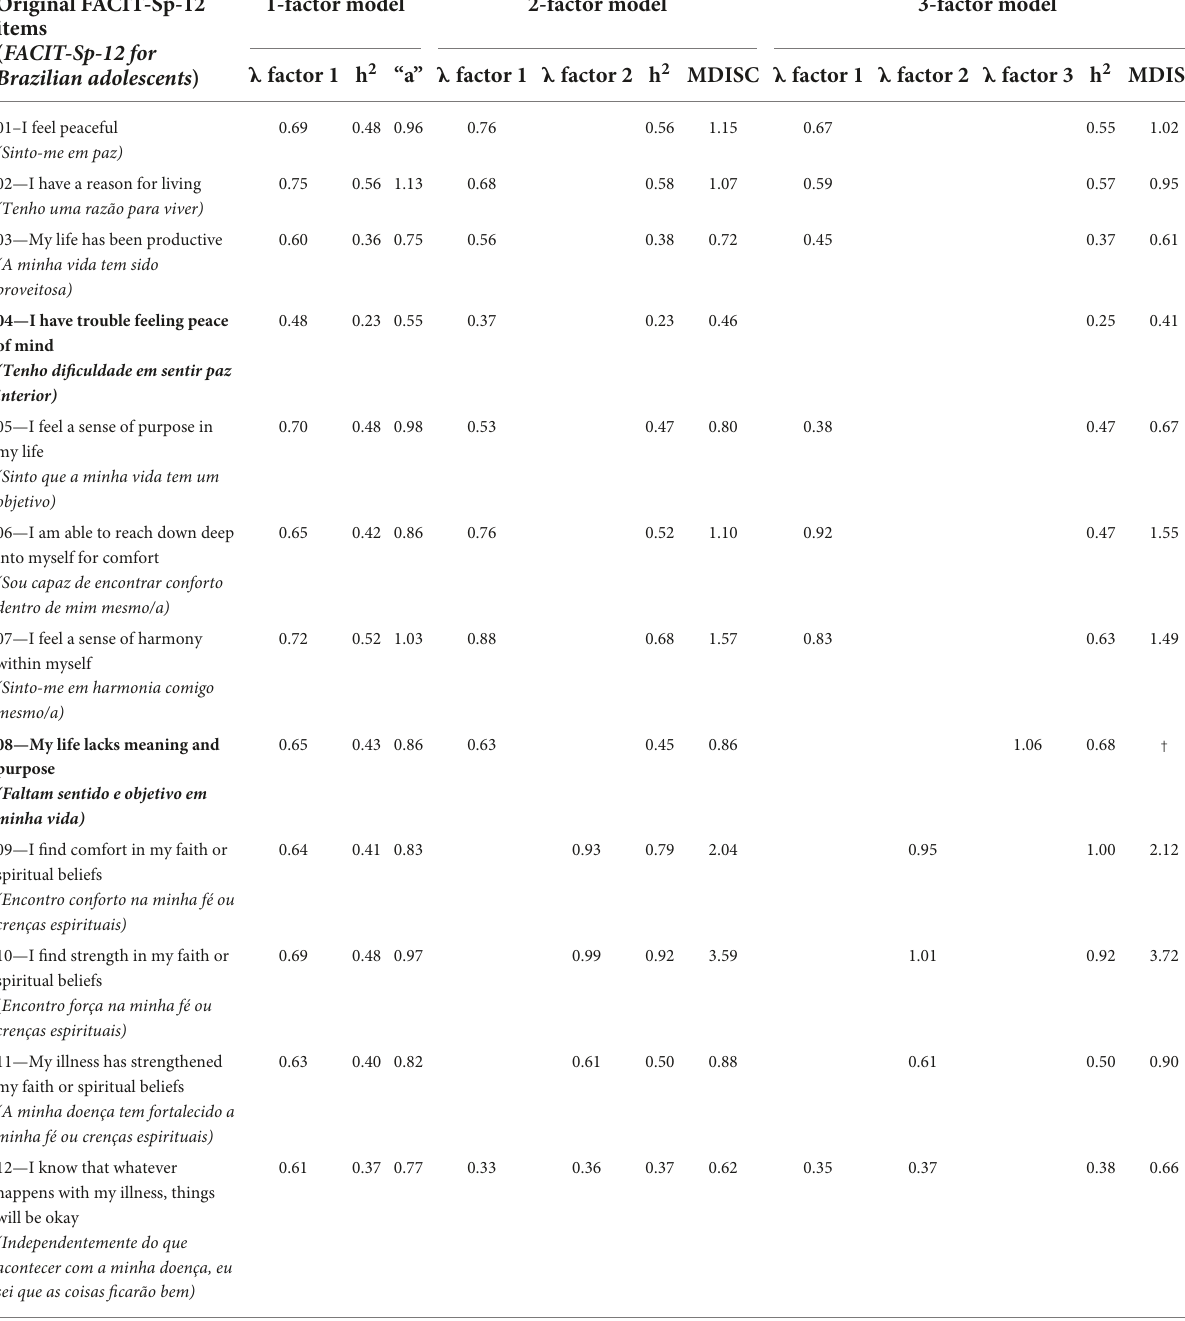
TABLE 2 Factor loading, communalities and item discrimination of one-, two-, and three-factor models of the FACIT-Sp-12. Original FACIT-Sp-12 items